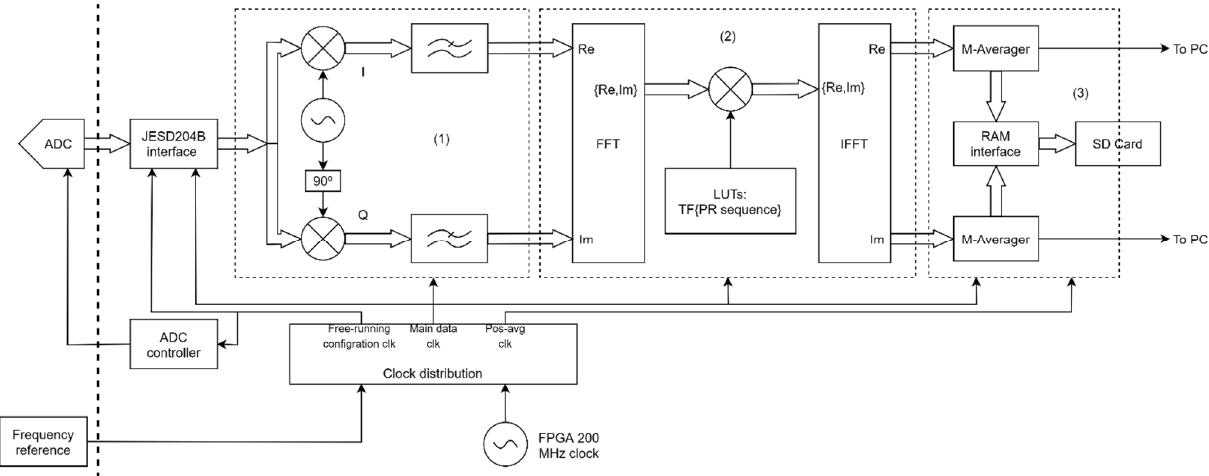
Figure 5. Scheme of the FPGA design at the receiver.